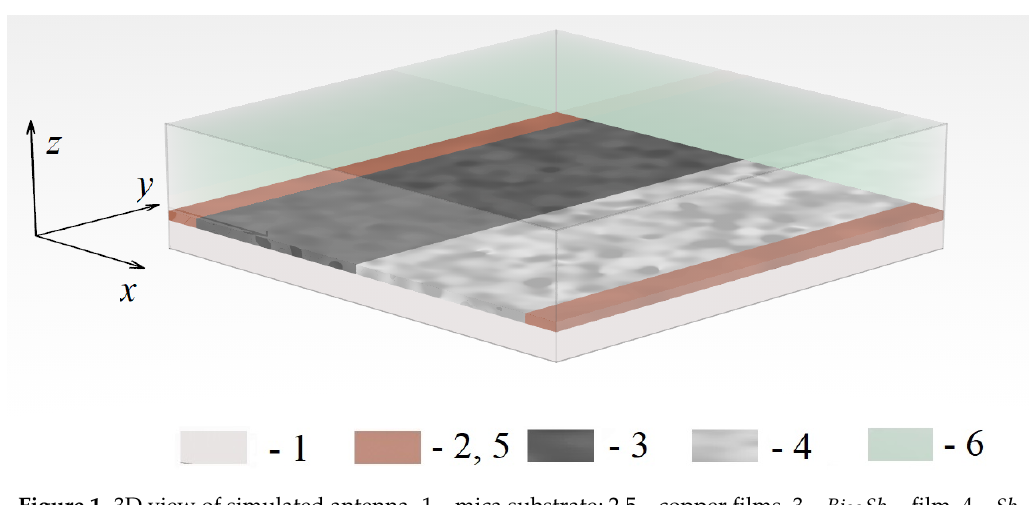
Figure 1. 3D view of simulated antenna. 1—mica substrate; 2,5—copper films, 3— Bi 88 Sb 12 film, 4— Sb film, 6—vacuum chamber.